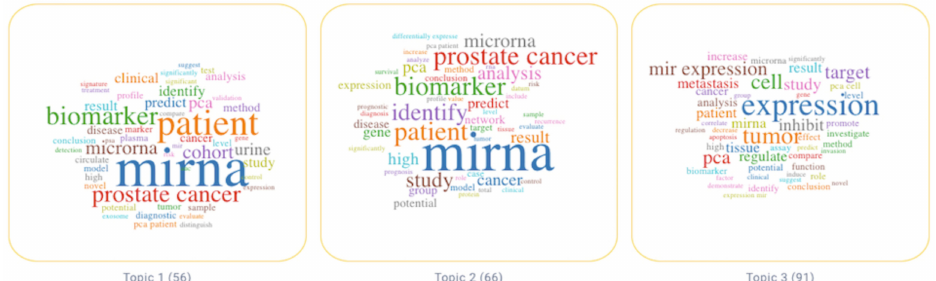
Figure 3. Word cloud highlighting the importance of the topic